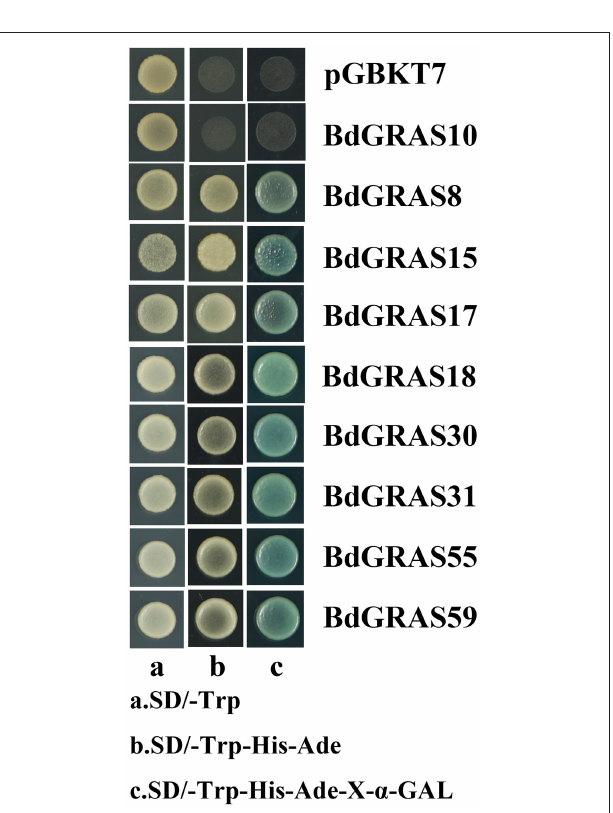
FIGURE 7 | Analysis of Brachypodium distachyon GRAS protein transcription